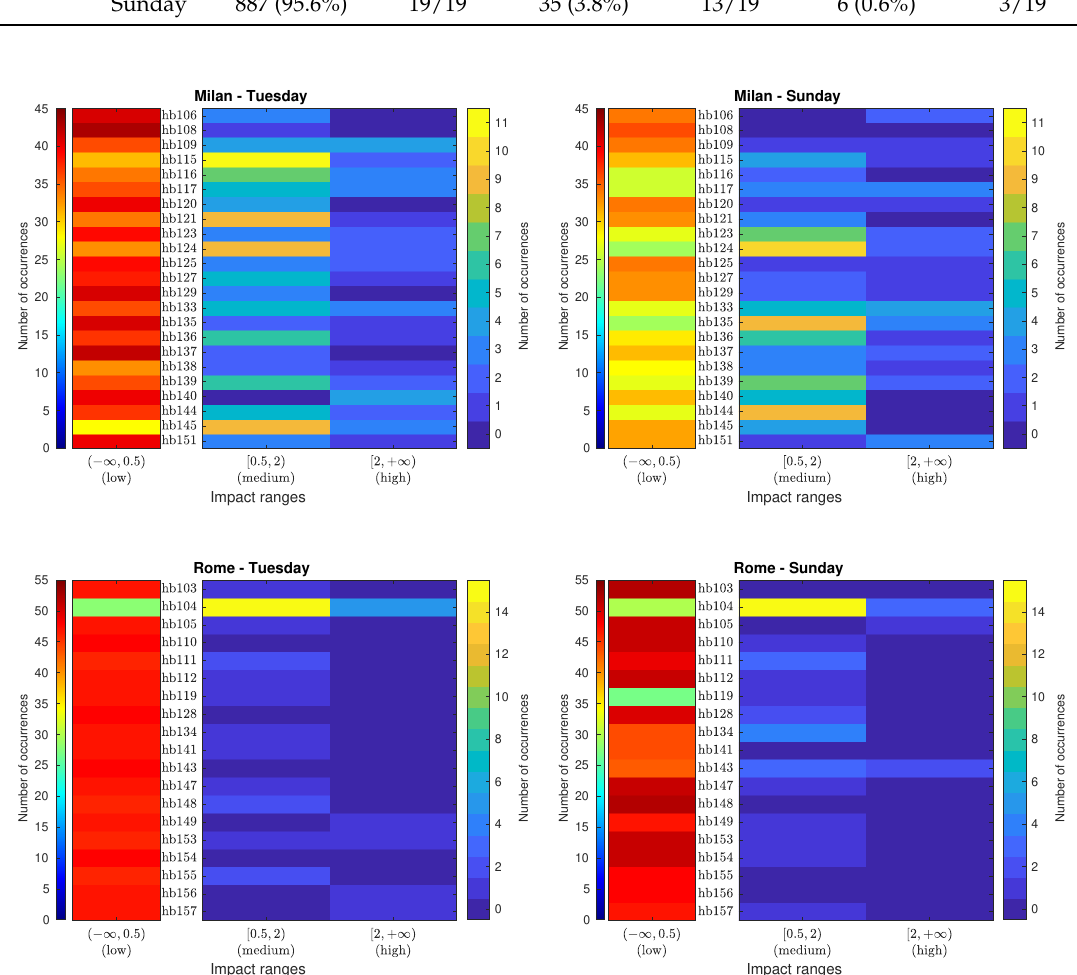
Figure 4. Aggregate impact histogram matrices (obtained using integration time T = 300 s) categorized in three impact ranges (low, medium and high) for the urban (Milan) and suburban (Rome) environments obtained from a weekday (Tuesday) and weekend day